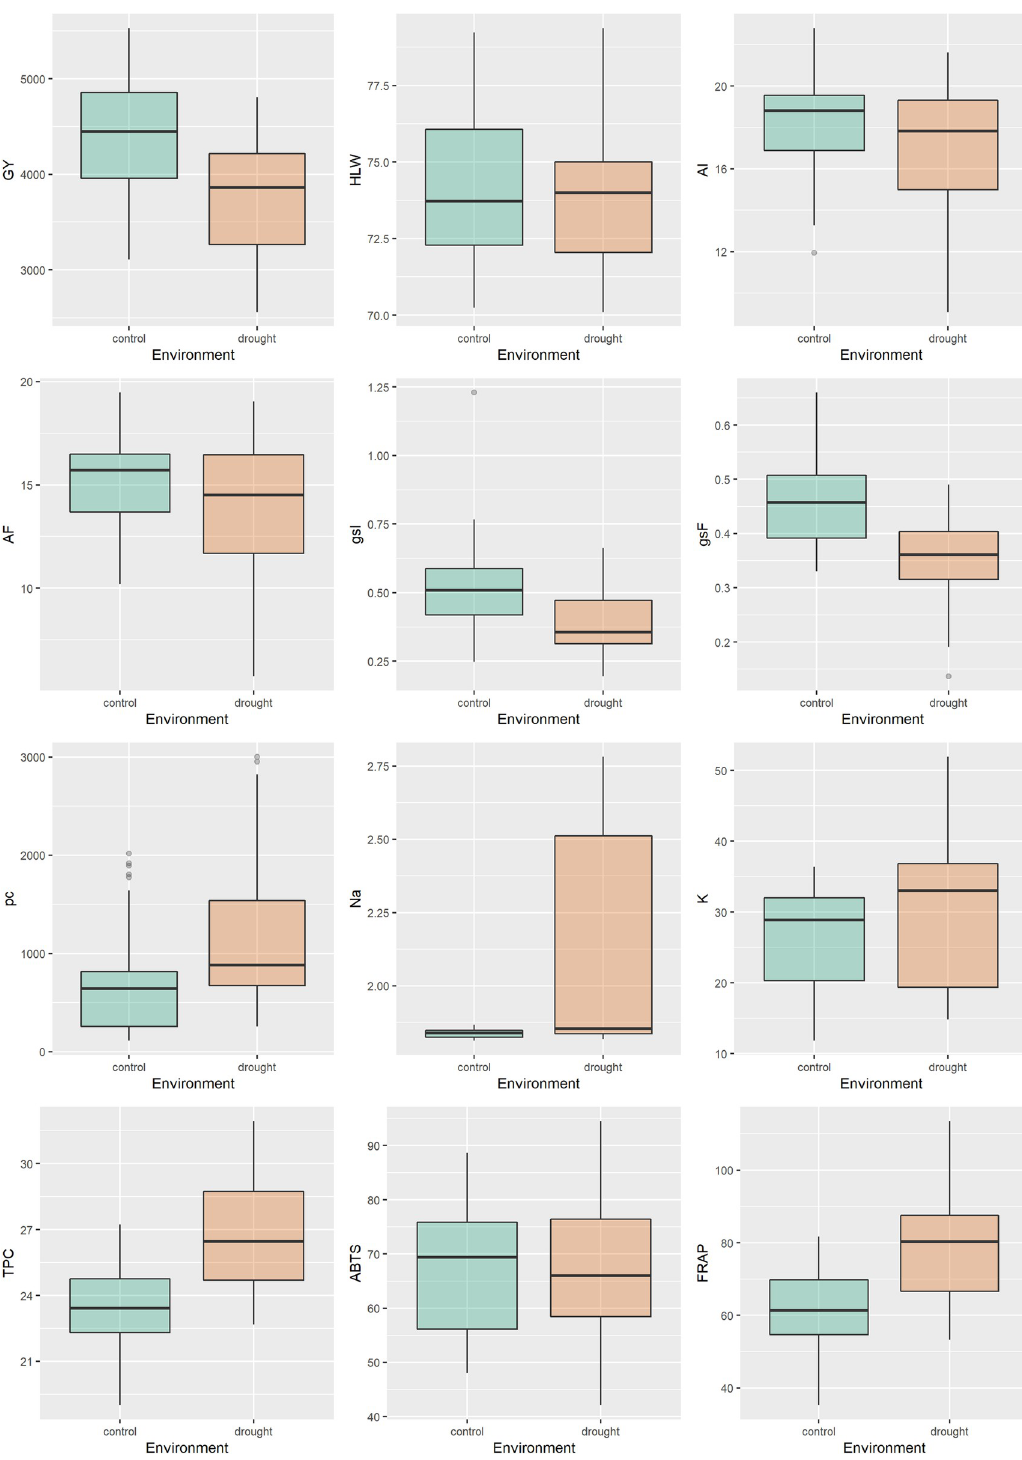
Fig 1. Results for box-plot of variables measured in 18 wheat genotypes under the two conditions of control and drought. Grain yield (GY, kg ha -1 ), hectolitre weight (HLW, kg hL − 1 ), initial and final liquid photosynthesis (AI and AF μ mol de CO 2 m - 2 s -1 ), initial and final stomatal conductance (gsI and gsF mol H 2 O m -2 s -1 ), proline content (pc, μ g g -1 ), sodium (Na) and potassium (K) (Na and K, mg g -1 ) total phenolic compounds (TPC, mg GAE g -1 ) and antioxidant activity by ABTS (mM TEAC g -1 ) and FRAP (mM Fe +2 g -1 )